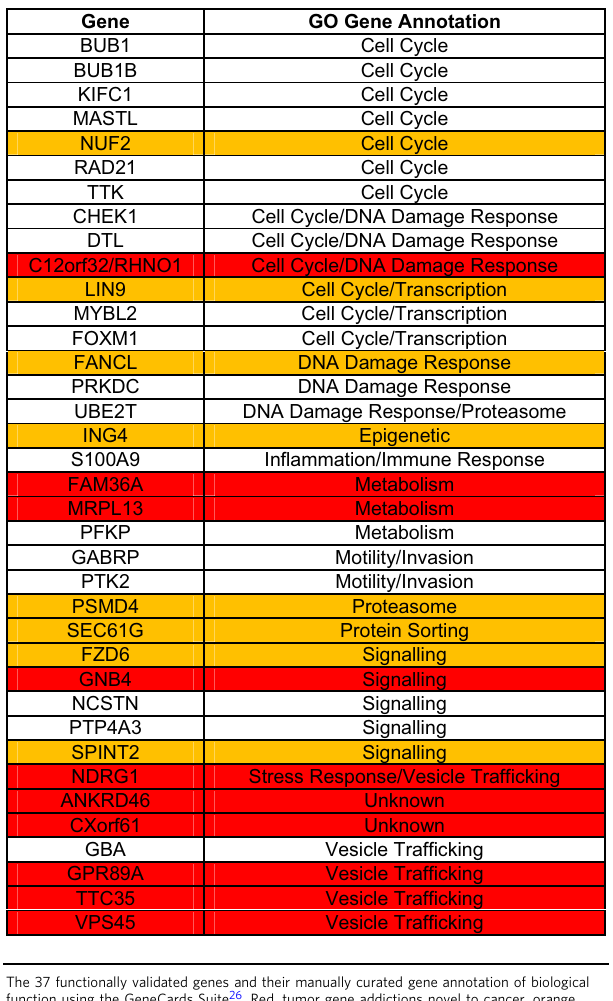
Table 1 Functional annotation of validated genes